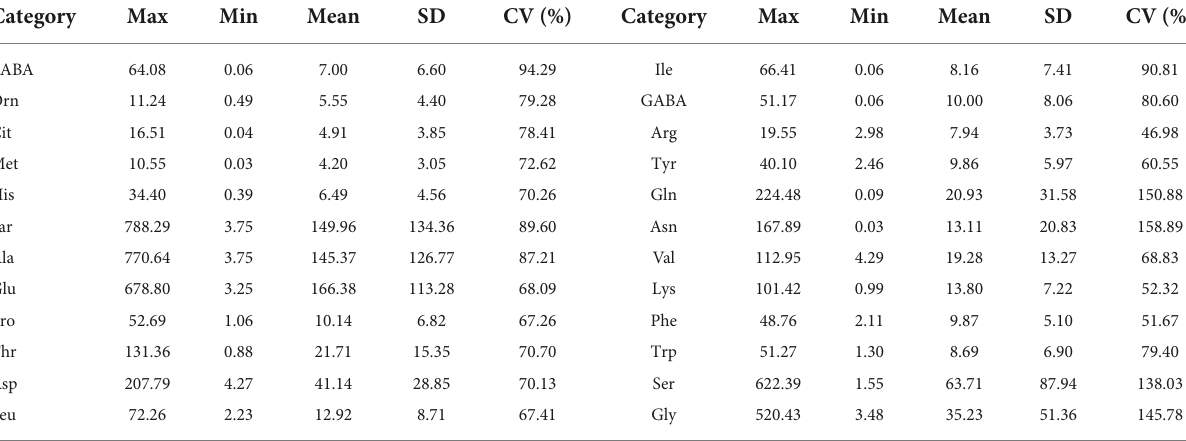
TABLE 1 Descriptive statistics of various amino acid contents in fresh leaves for the whole datasets ( µ mol/L).